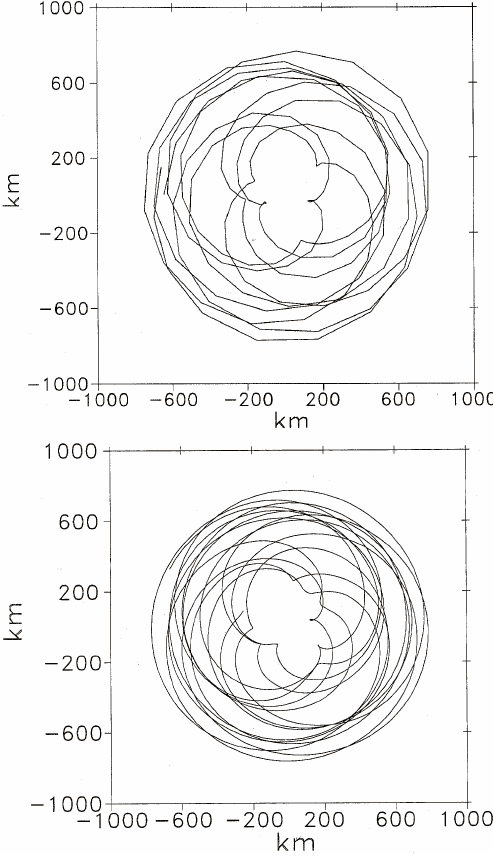
Fig. 2. The two examples of the solar orbit due to the inner